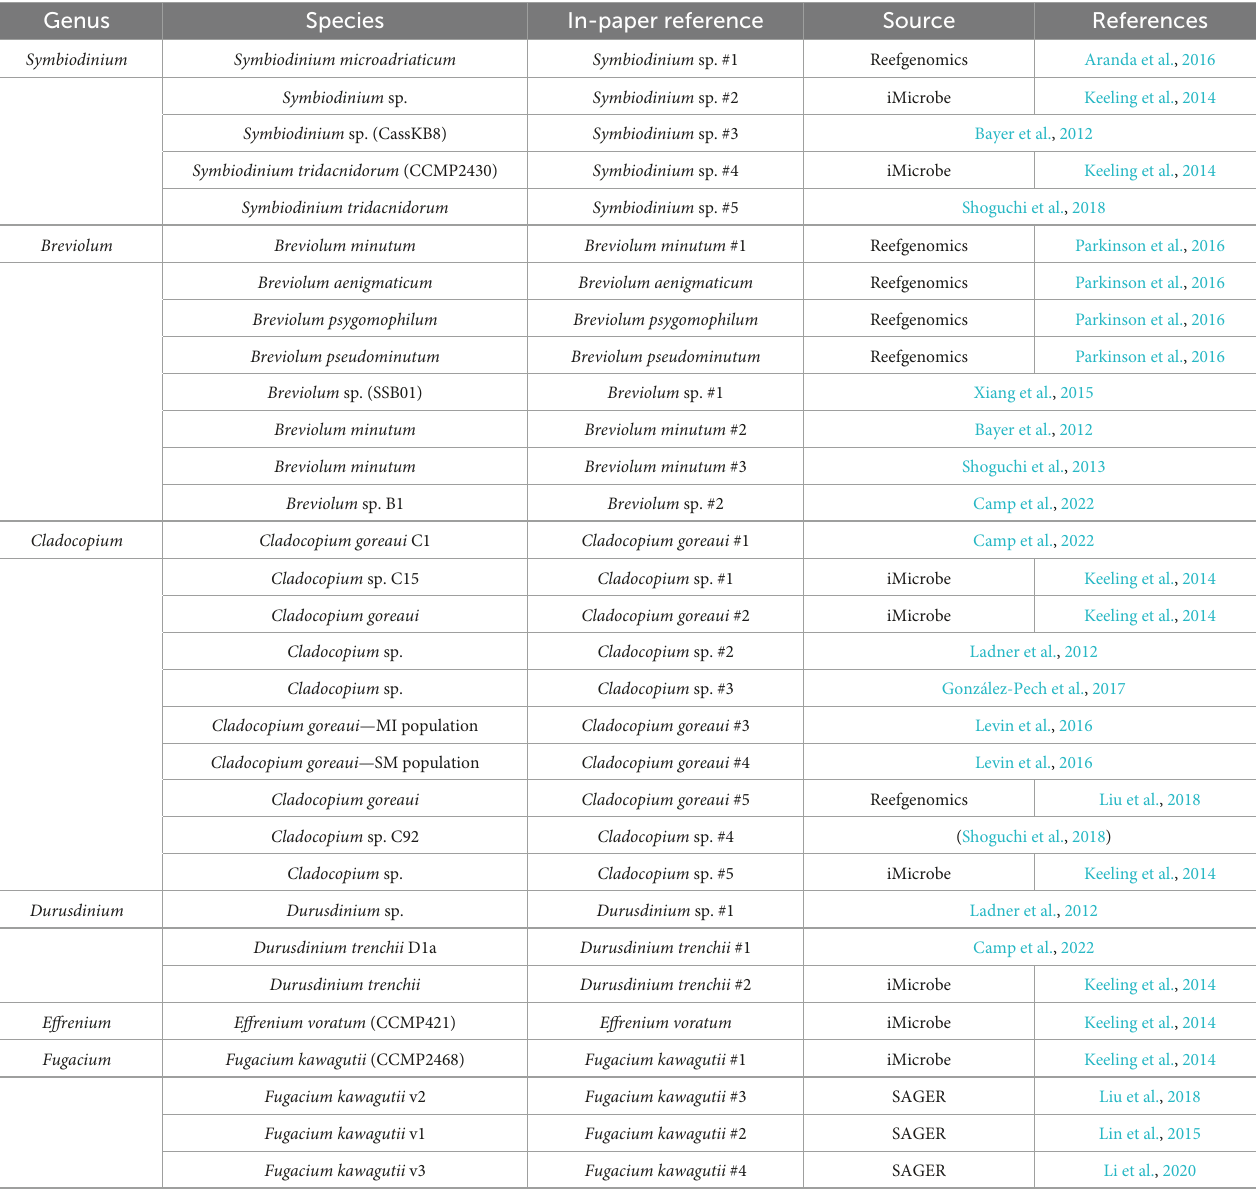
TABLE 1 The Symbiodiniaceae datasets used for